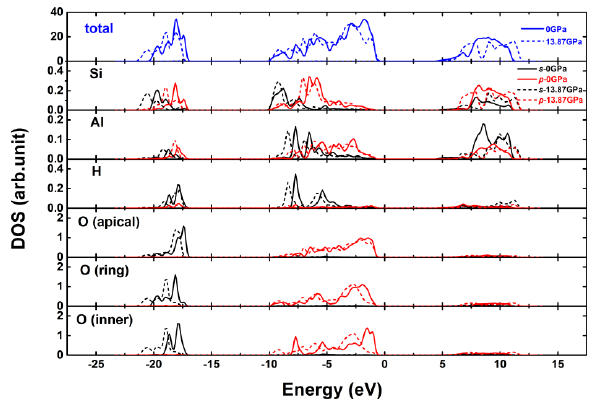
Figure 6. The total and partial density of states of pyrophyllite [Al 4 Si 8 O 20 (OH) 4 ] at 0 GPa and 13.87 GPa. The blue solid curve-the total density of states at 0 GPa; the blue short dash curve-the total density of states at 13.87 GPa; the black solid curve-the partial density of s states at 0 GPa; the red solid curve-the partial density of p states at 0 GPa; the black short dash curve-the partial density of s states at 13.87 GPa; the red short dash curve-the partial density of p states at 13.87 GPa.